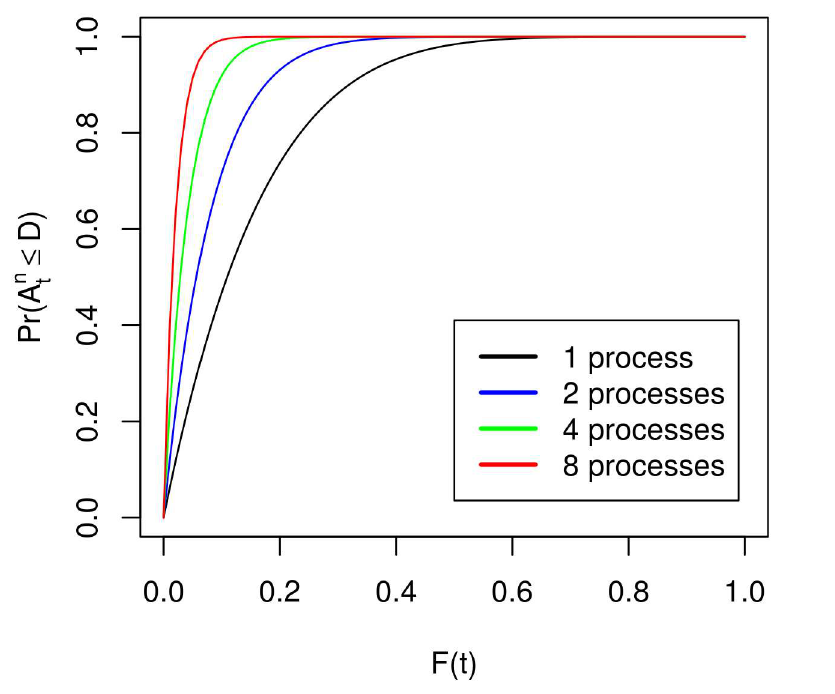
Fig 1. Probabilities with identical restart times. Displayedfor 6 restarts.